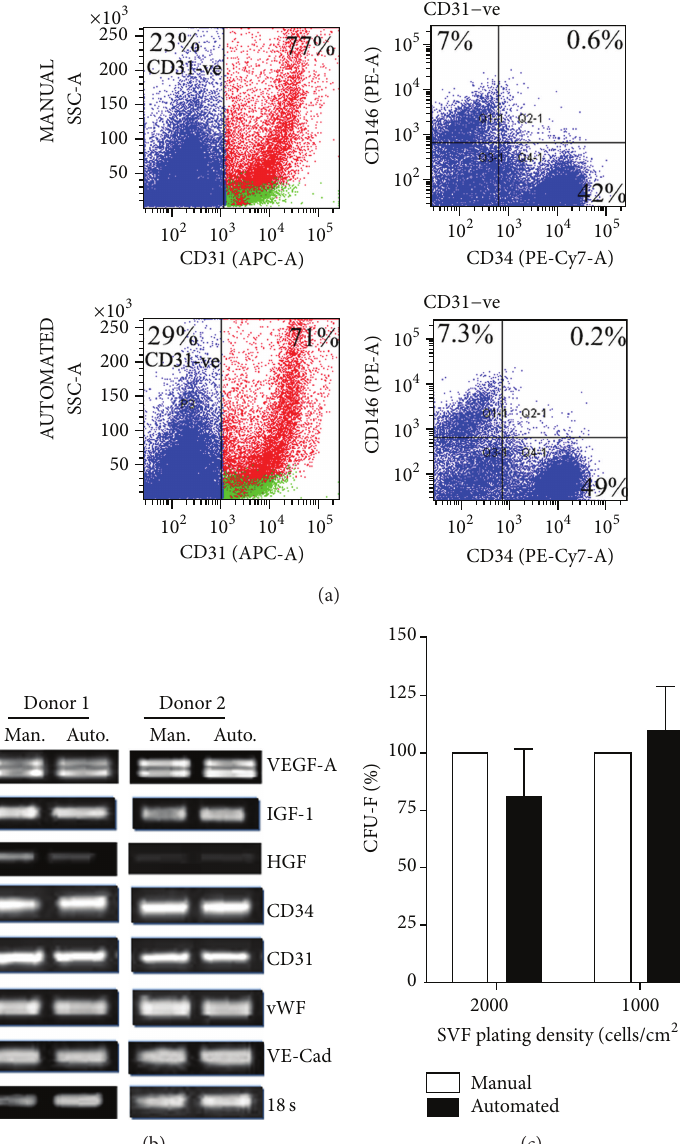
Figure 5: Phenotypic and functional characterization of SVF isolated by the manual and automated process. (a) Detection of pericytes in SVF isolated by the manual and automated process. The CD31 − ve cells in the SVF were gated (depicted in blue) and analyzed for expression of CD34 and CD146. Values represent percentage of CD31 − ve cells expressing CD34 or CD146. Data shows a representative set of plots from four individual donors in each group. (b) Semiquantitative RT–PCR analysis for expression of angiogenic markers in SVF obtained from manual and automated process. 18s ribosomal RNA expression was used to normalize cDNA concentration for each sample set. Data depicts gene expression in two pairs of samples out of four pairs of individual donors analysed. Man: manual; Auto: automated. (c) Clonal expansion potential of SVF obtained by manual and automated process. Data represents mean number of CFU-F obtained for each plating density from four individual donors, each assayed in duplicate. Errors represent SD from four individual